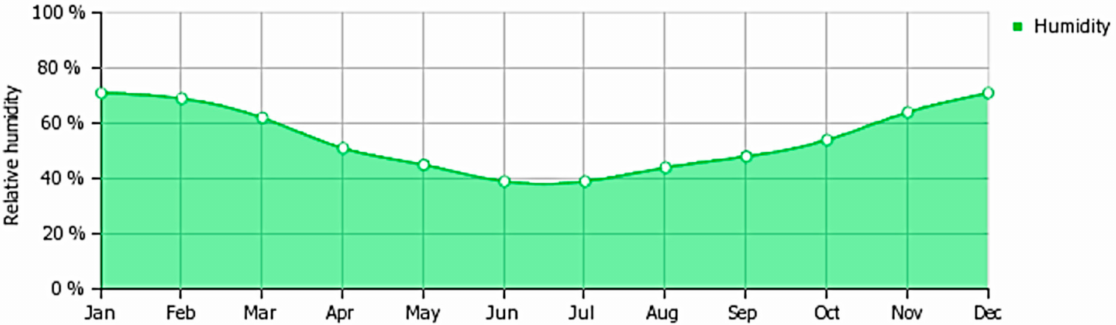
Figure 8. The mean monthly precipitation of North-Cyprus